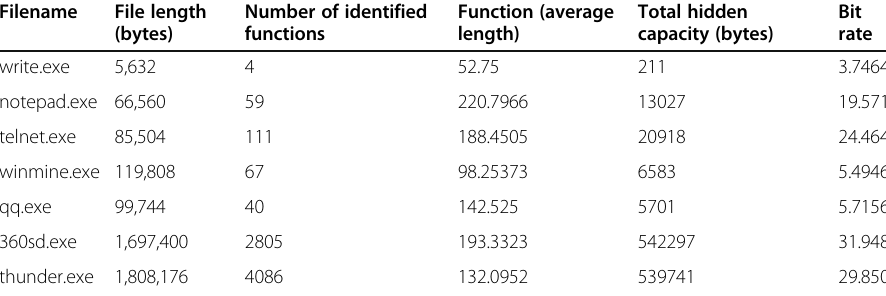
Table 2 Embedded capacity and bit rate of function migration